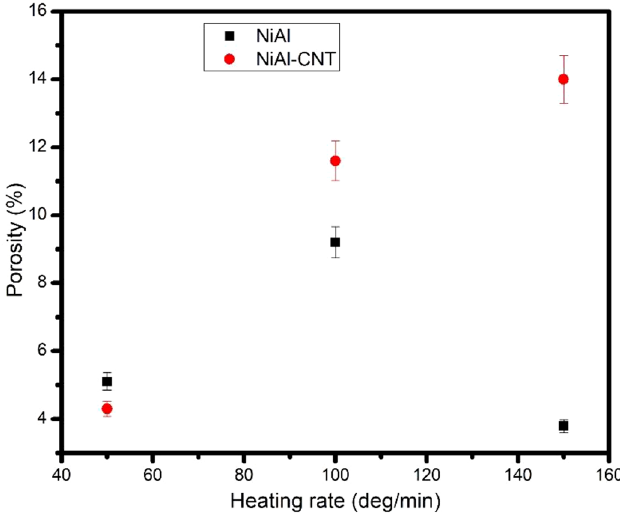
Fig. 3. The illustration of the porosity with heating rate (a) NiAl, and (b)